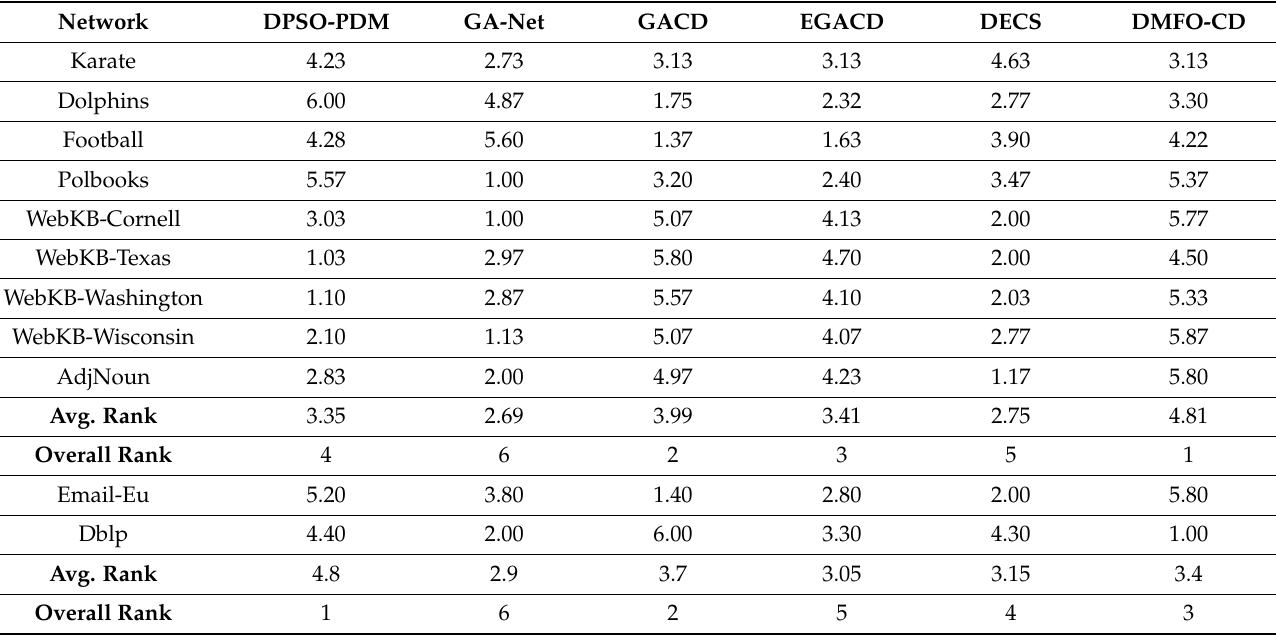
Table 5. The Friedman test on NMI.